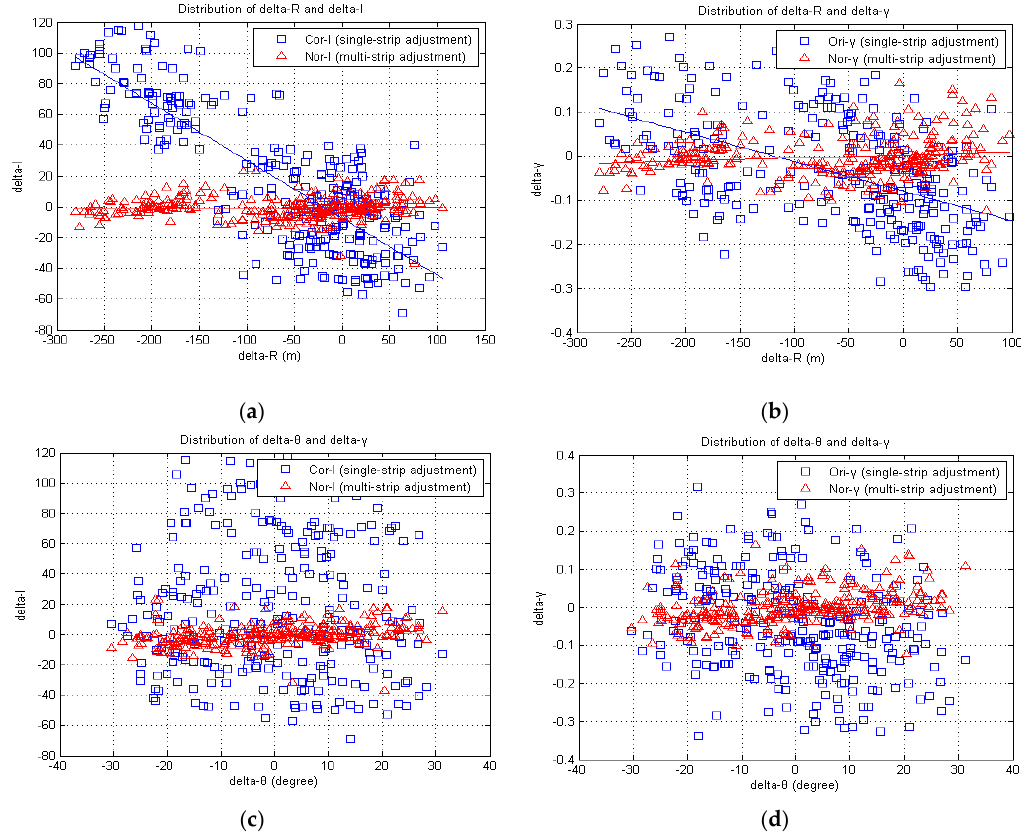
Figure 7. Distributions of delta intensity and delta backscattering coefficient: ( a ) the distributions of delta intensity and delta slant range; ( b ) the distributions of delta backscattering coefficient and delta slant range; ( c ) the distributions of delta intensity and delta incident angle; and ( d ) the distributions of delta backscattering coefficient and delta incident angle. Table 4. Comparison of block and pair-wise adjustments.